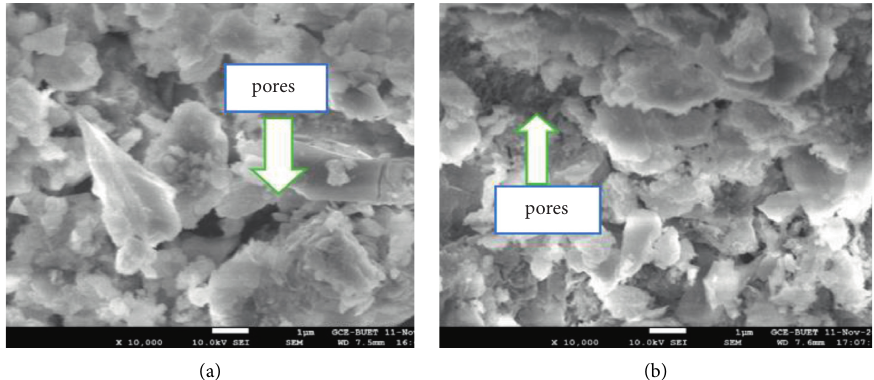
Figure 8: SEM imaging of conventional concrete. (a) 25MPa plain concrete. (b) 35MPa plain concrete.